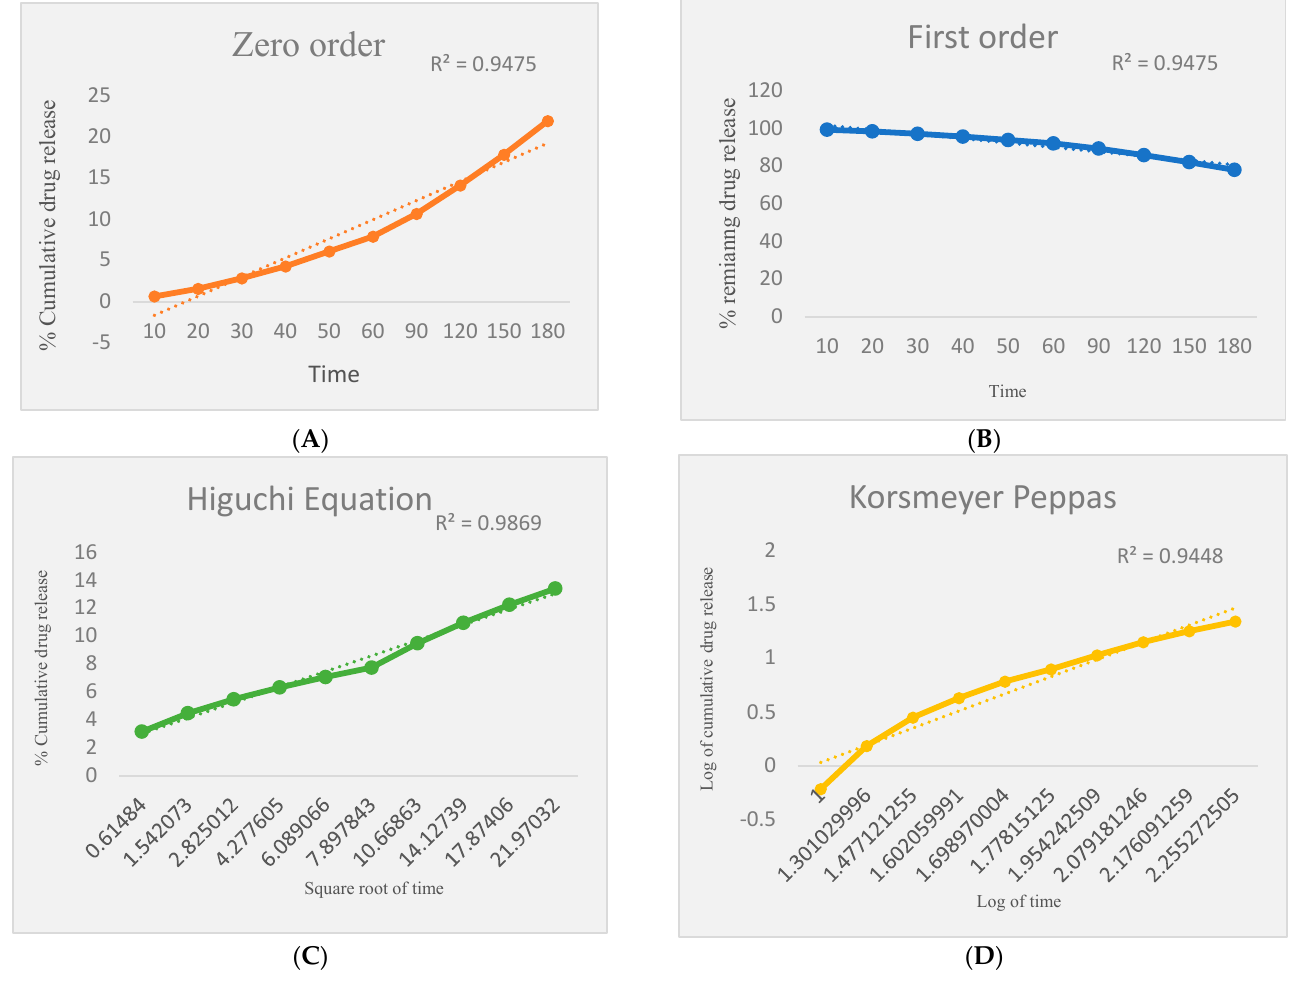
Figure 4. Higuchi’s kinetics drug release in the formulation. ( A ) Zero order, ( B ) first order, ( C ) Higuchi equation, ( D ) Korsmeyer Peppas. Table 4. Ex vivo diffusion study of